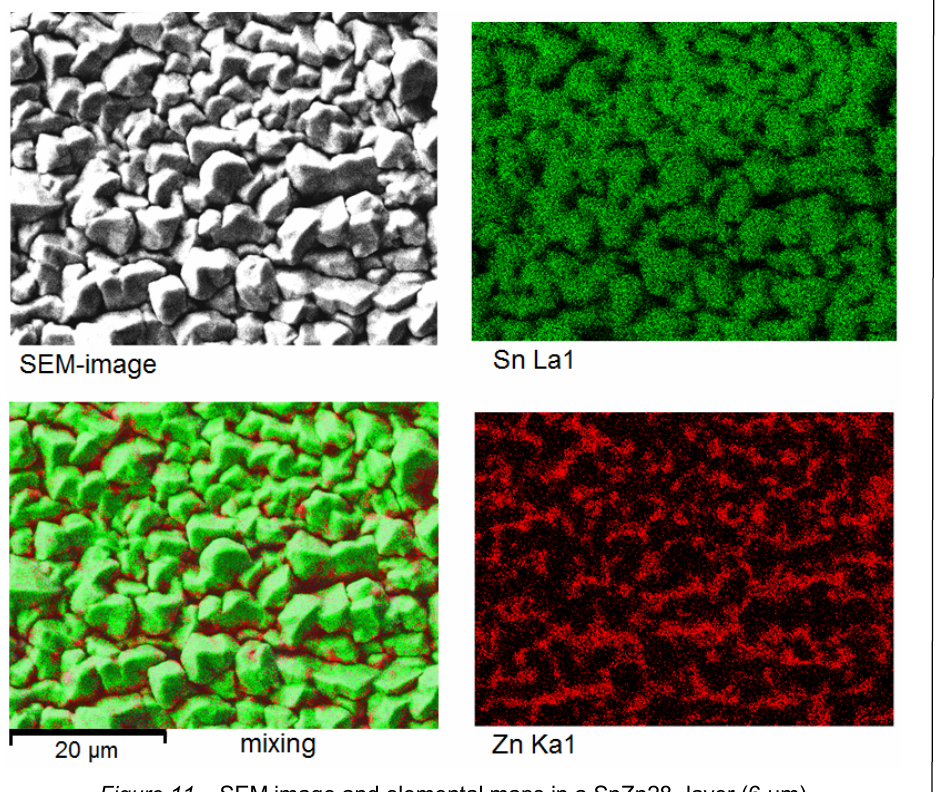
Figure 11 – SEM image and elemental maps in a SnZn28- layer (6 µm) Рис . 11 – SEM изображение и карточка элементов одного слоя SnZn28 (6